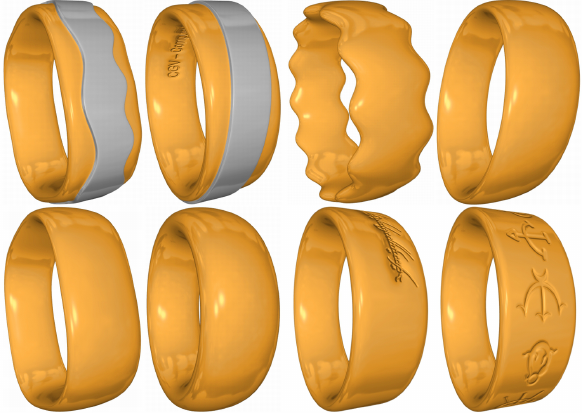
Figure 3: The presented generative description is able to produce a large variety of wedding rings. Features like engravings, re- cesses, different materials, unusal forms and gems can be created and